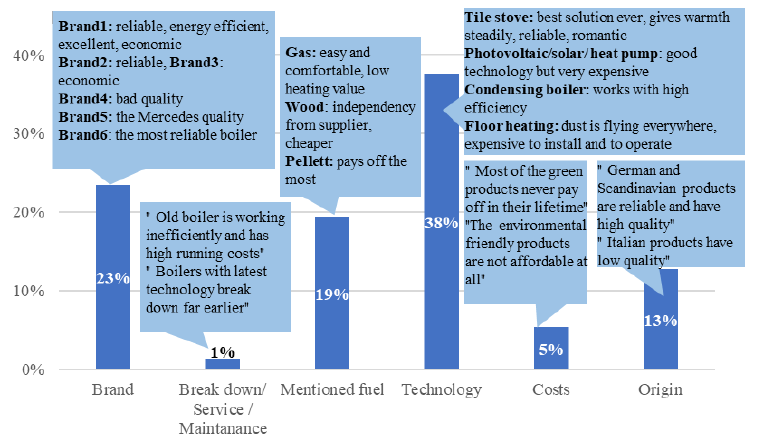
Figure 3. Common knowledge of heating products.